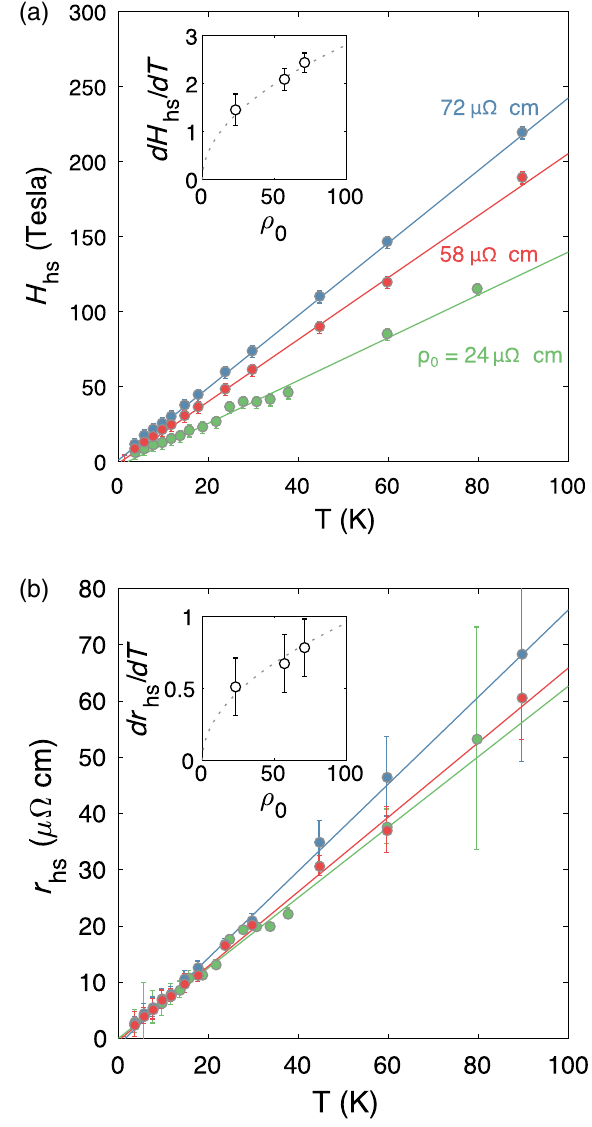
FIG. 7. Hot-spot parameters in BaFe 2 ð As 1 − x P x Þ 2 with x ¼ 0 . 31 . (a) Characteristic field H as a function of temperature hs with a linear fit for each sample. The inset shows the slope of H ð T Þ versus the residual resistivity. The dotted line shows the hs expected ρ 1 = 2 0 dependence according to Eq. (7) of the hot-spot model. (b) Hot-spot MR amplitude. The inset shows the slope of ð T Þ versus the residual resistivity with a fit to the expected ρ 1 = 2 r 0 hs dependence. Error bars are derived from the confidence intervals of the hot-spot fits and the linear fits in the present